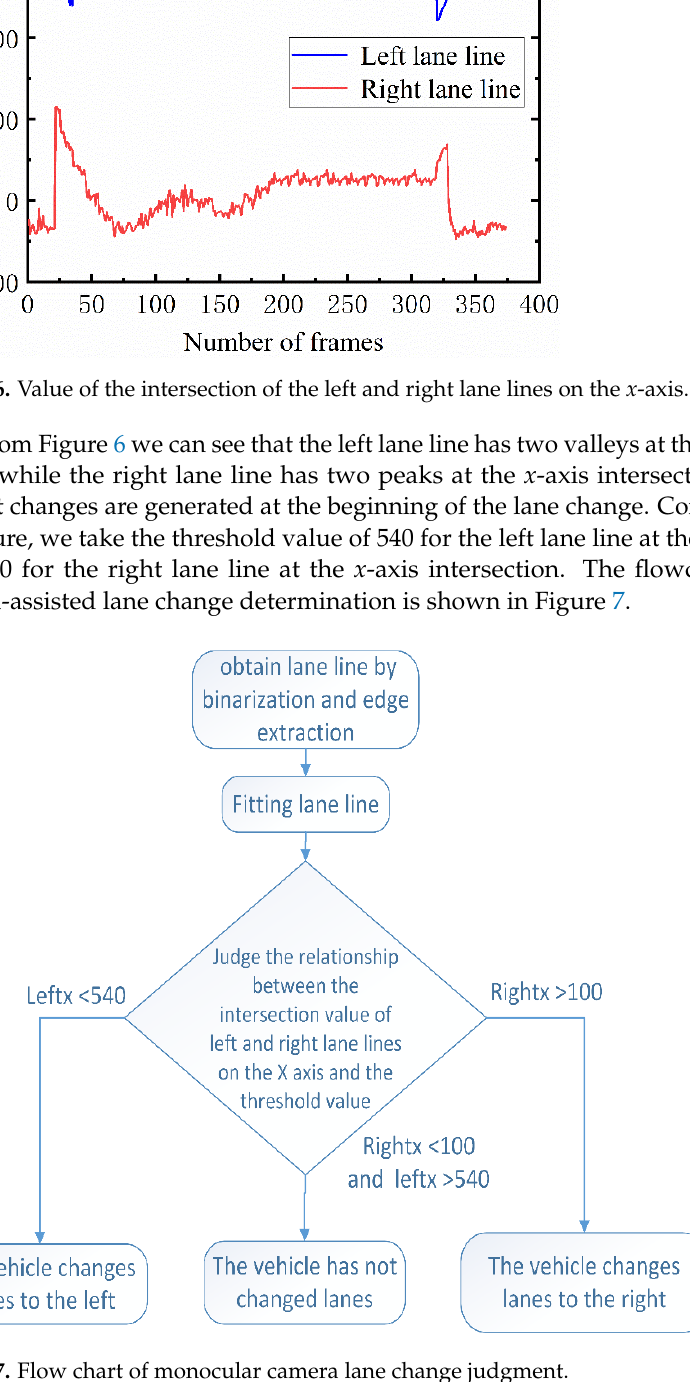
Figure 5. Actual photo of lane in tunnel: ( a ) Vehicle ROI figure; ( b ) Lane Line Fitting Diagram.